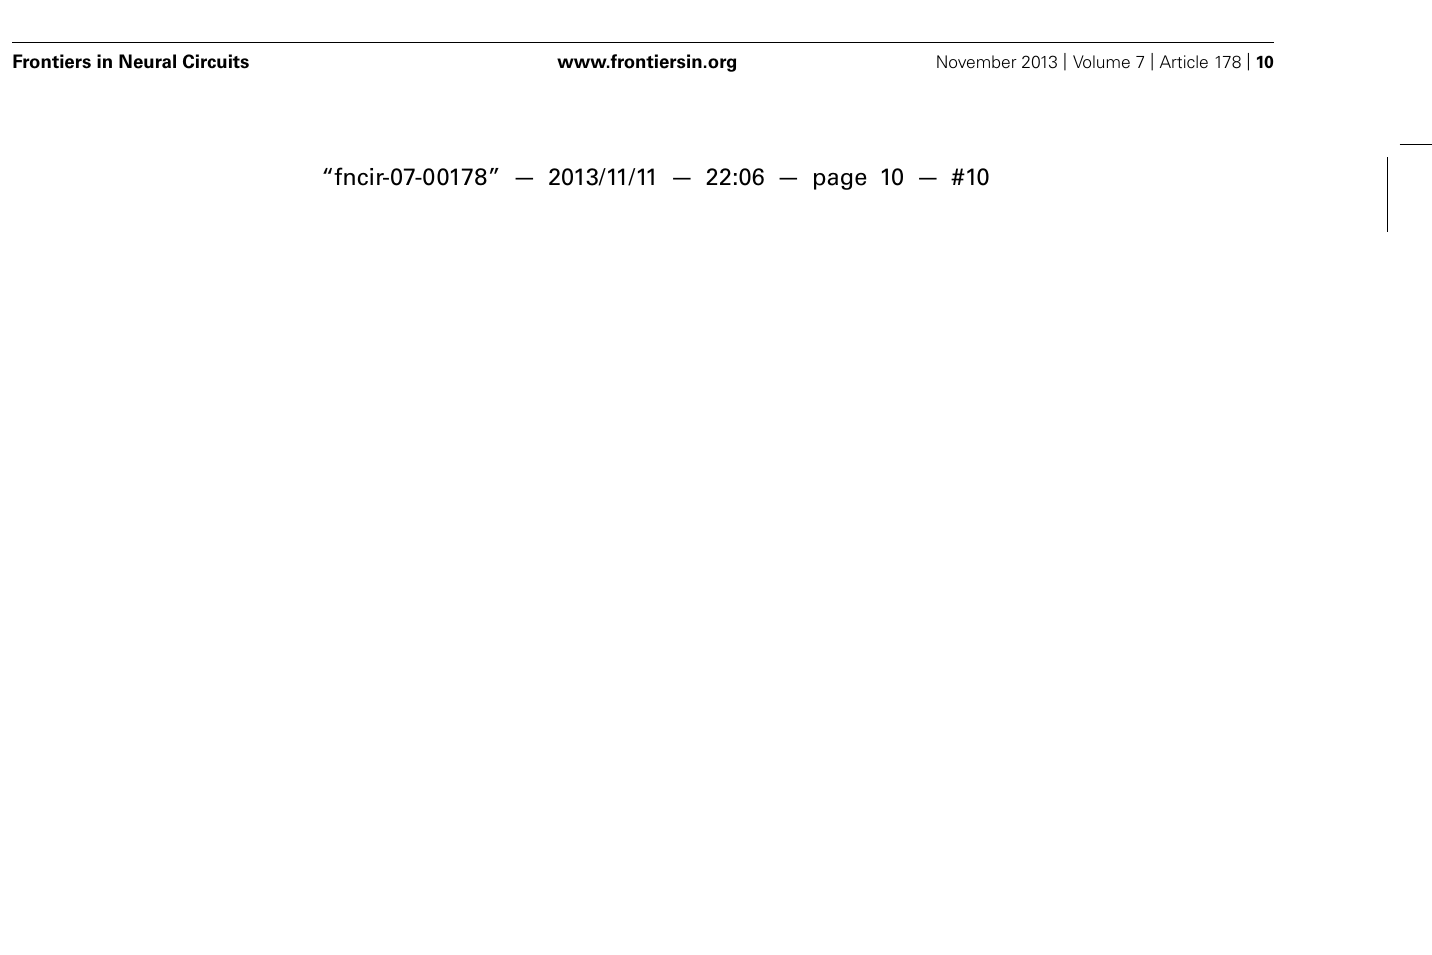
Table 2 | Sleep and wake parameters in larval zebrafish using a 60 immobility threshold. Threshold (s) Percent time of night (%) Mean SE